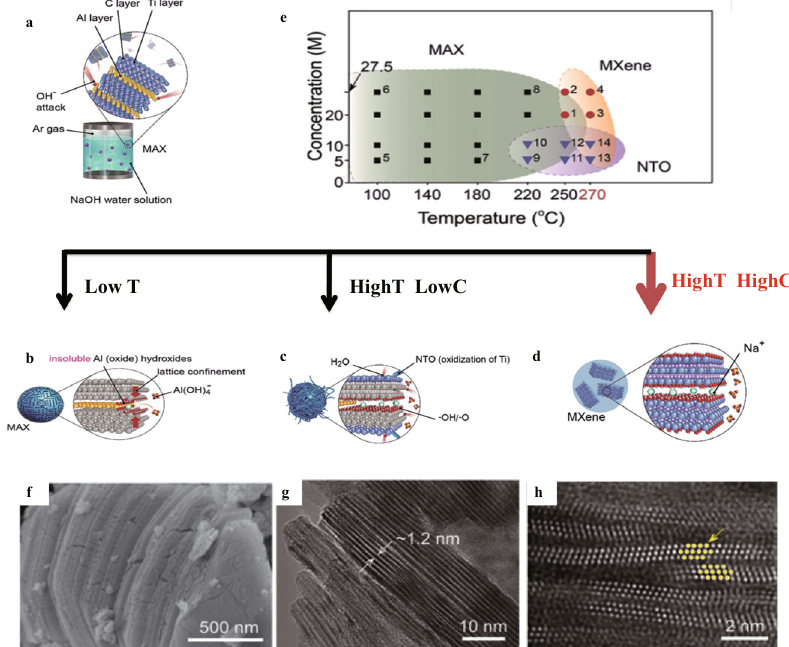
Fig. 3 The synthesis of MXenes from MAX phase by NaOH etching. a – d The NaOH etching of Ti 3 AlC 2 under different temperatures and NaOH concentrations. e The Ti 3 C 2 T X products under different hydrothermal treatment conditions. f SEM, g TEM, and h HAADF-STEM characterizations of the Ti 3 C 2 T X fl akes. The bright spots in h indicate Ti atoms 54 . Copyright 2018,